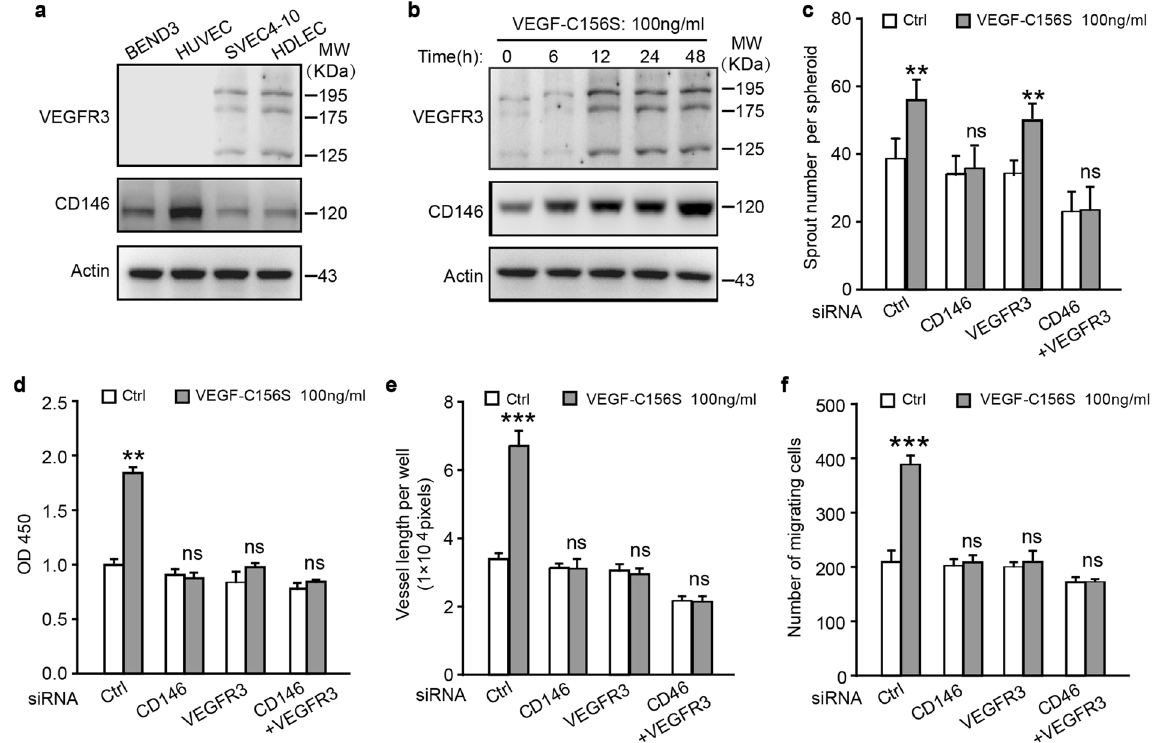
Figure 1. CD146 is expressed in LEC and regulates LEC activation induced by VEGF-C. ( a ) WB analysis of CD146 and VEGFR-3 expression in four different endothelial cell lines. ( b ) Serum-starved HDLEC cells were treated with VEGF-C156S (100 ng/ml) for different time intervals. The expression of CD146 and VEGFR-3 was determined by WB. ( c – f ) HDLEC cells, transfected with siRNA of control, CD146, VEGFR-3 or combination of CD146 and VEGFR-3, were subjected to spheroid sprouting assay ( c ), proliferation assay (d), tube formation assay ( e ) and transwell migration assay ( f ). VEGF-C156S was applied at the indicated concentration. Data were expressed as means ± SEM from 3 independent experiments (n = 3 in each group of c – f ). Significant difference was determined by Student’s t- test ( * P < 0.05; ** P < 0.01; *** P < 0.001; ns, no significant difference). Full- length blots are presented in Supplementary Fig.